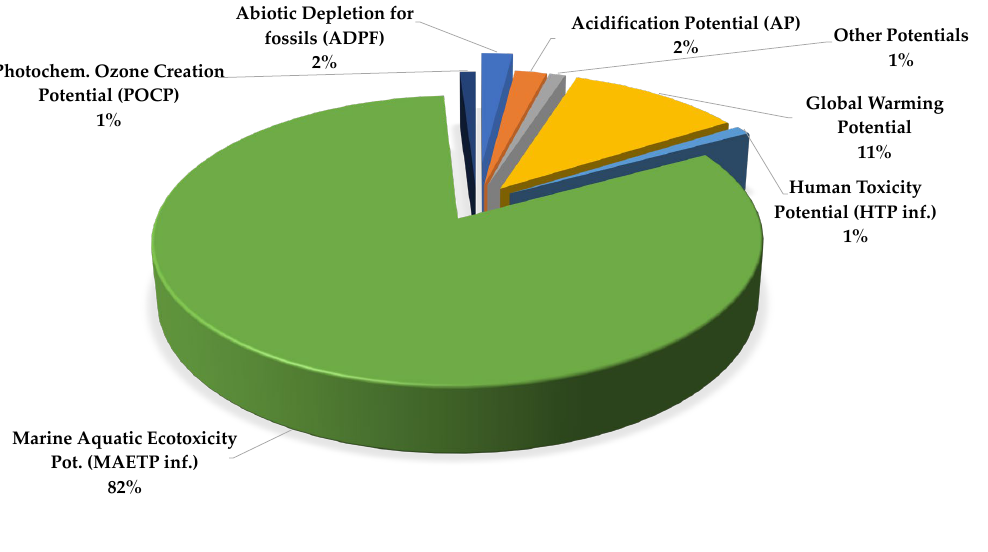
Figure 8. Environmental impact categories for Scenario 2 of the end-of-life stage with transport (functional unit: food waste of 0.05 kg. Normalisation reference: CML 2016, EU 25 + 3, year 2000, excl. biogenic carbon. Weighting method: thinkstep LCIA Survey 2012, Europe, CML 2016, excl. biogenic carbon).